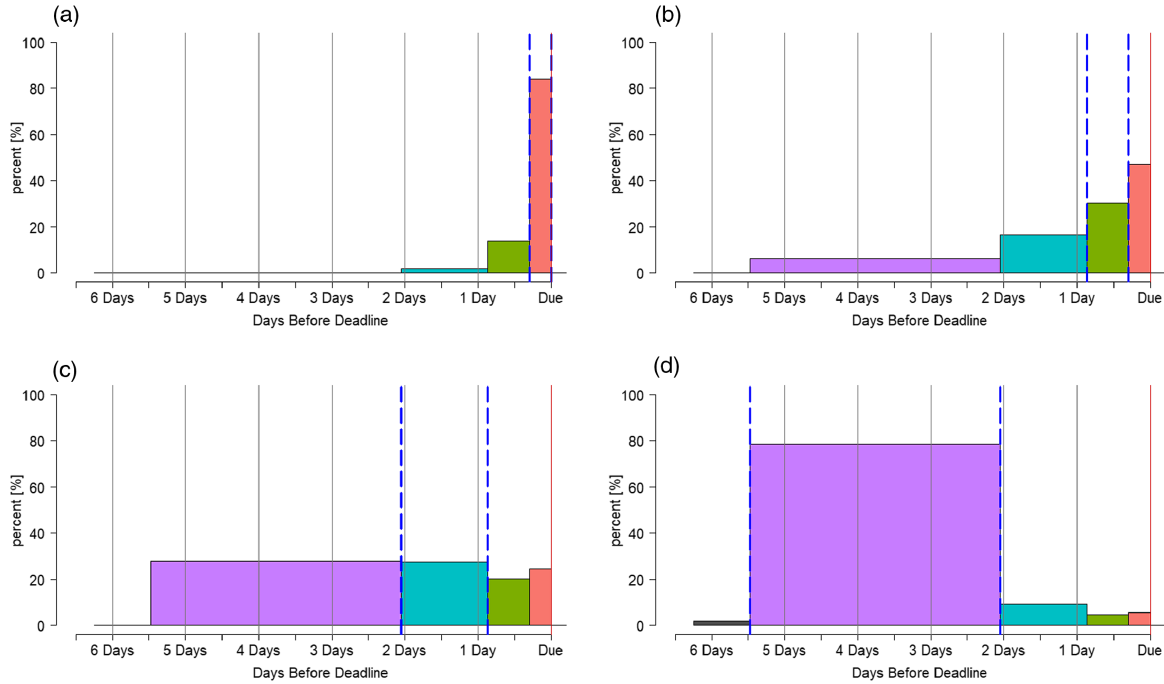
FIG. 3. For each class, we plotted a histograms of student completion times for all ES assignment completed. Figure 3(a) is for completion class 1 students, (b) class 2 students, (c) class 3 students, and (d) class 4 students. The histogram bin widths are based on ranges of completion times for each completion class. The bins were from 0 to 7.1 h, 7.1 to 20.7 h, 20.7 to 49.2 h, and 49.2 to 131.2 h, representing the range of average times of students in class 1,2,3 and 4, respectively. The blue dashed lines are included to emphasize the window that corresponds to the completion class that is being plotted. For example, in Fig. 3(a), 80% of class 1 completion times are between 0 and 7 hours (i.e., between the two blue dashed